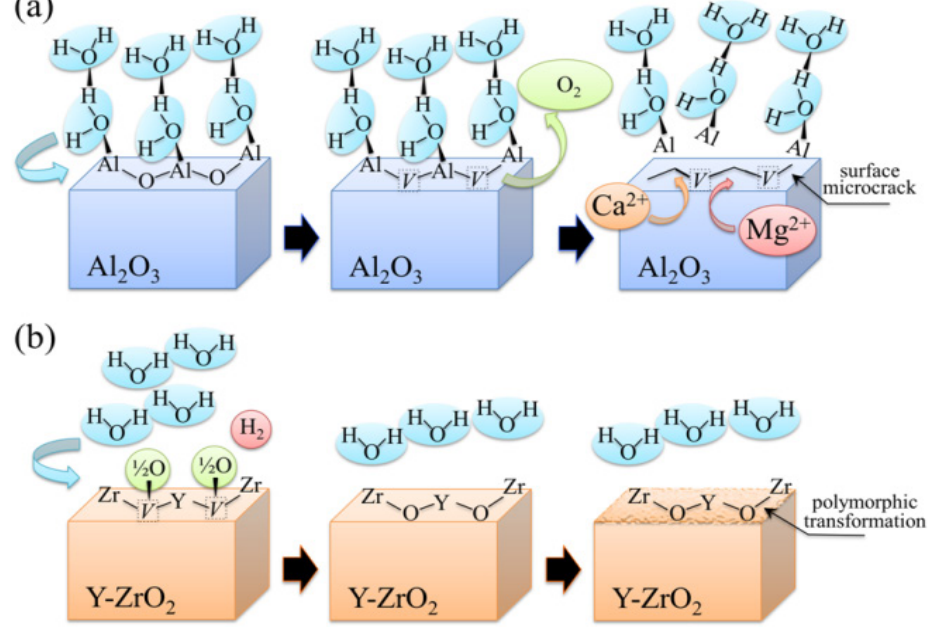
Figure 1. Drafts of the different behaviors of ( a ) alumina and ( b ) zirconia bioceramic surfaces in a biologically active environment with emphasis placed on their oxygen-sublattice